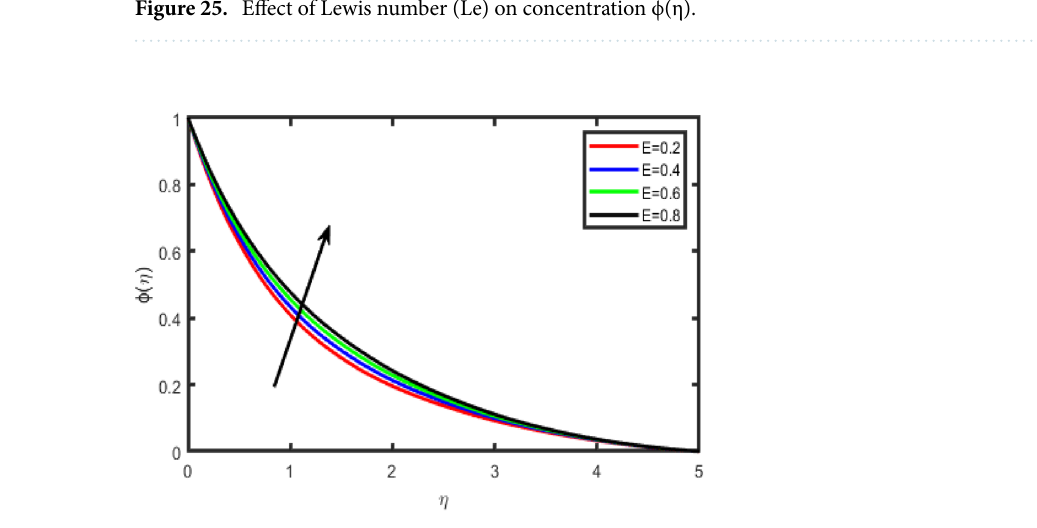
Figure 26. Effect of activation energy (E) on concentration ϕ(η).